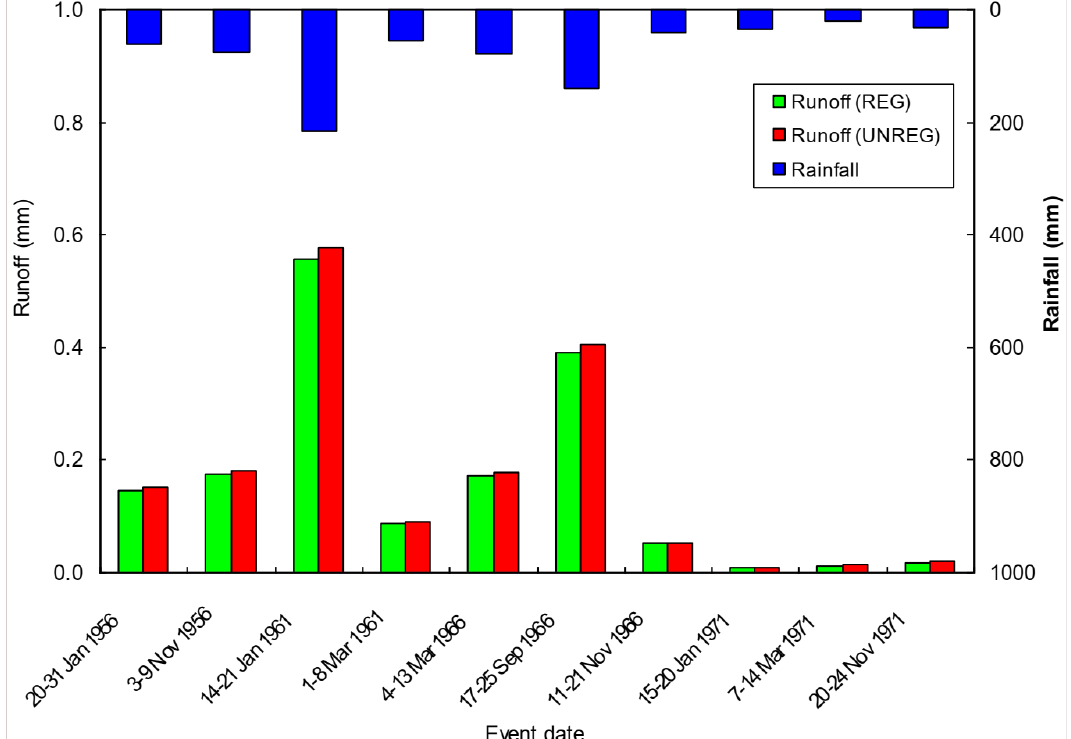
Figure 6. Rainfall height and surface runoff simulated by the HEC-HMS model in unregulated (UNREG) and regulated (REG) sub-catchments (Calabria, Southern Italy)—events are not reported on the time